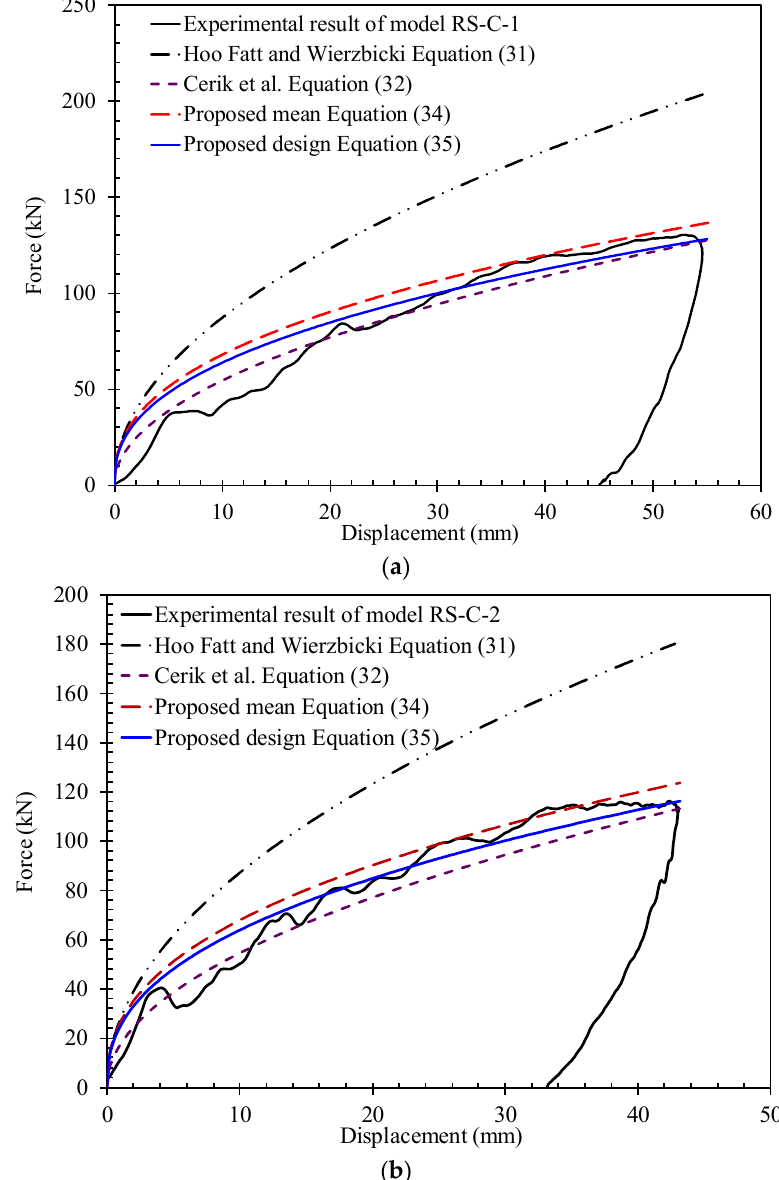
Figure 28. Comparison of predicted force-displacement relations using proposed formulations with other existing formulations for ring-stiffener cylinders: ( a ) Model RS-C-1; (b) Model RS-C-2.